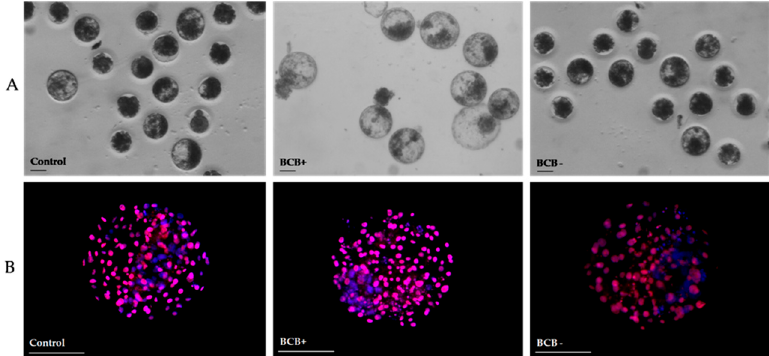
Figure 3. Representative phase-contrast light micrographs of blastocyst produced in vitro from cat oocytes selected by Brilliant Cresyl Blue (BCB) staining ( A ) and epifluorescence micrographs of cat blastocysts after differential staining ( B ). Inner cell mass appears in blue (Hoechst) and trophectoderm in red (propidium iodide). Scale bar = 100 µM.